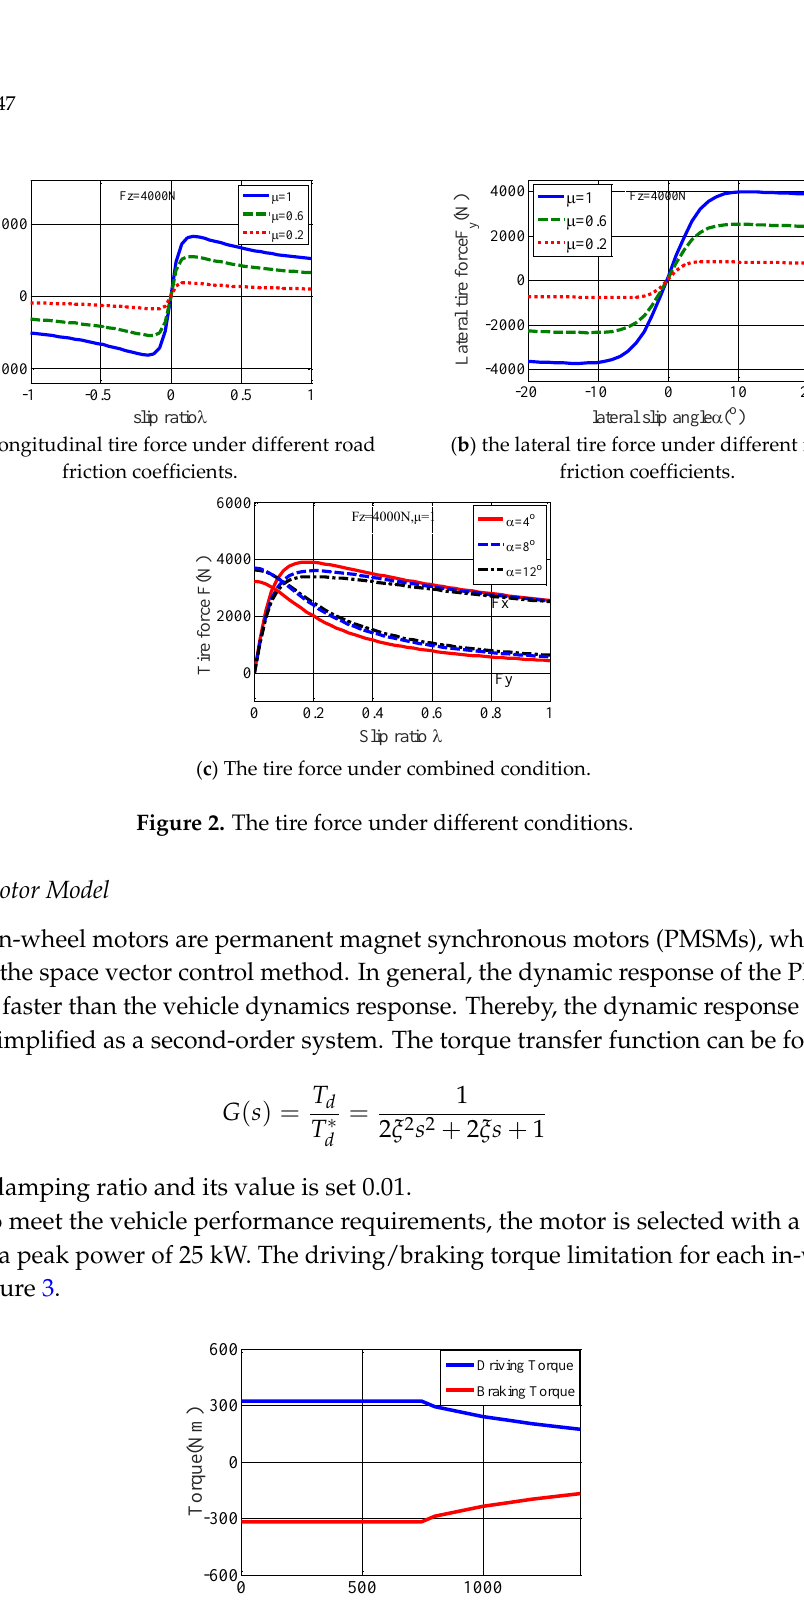
Figure 3. Driving torque and regenerative torque characteristics of in-wheel motor.